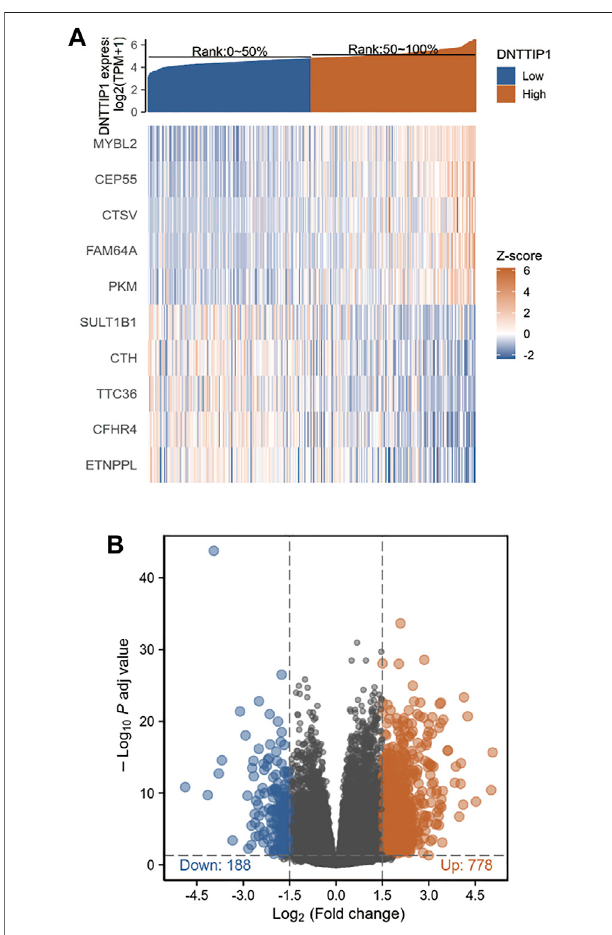
FIGURE 1 | Results of differentially expressed gene (DEG) analysis. (A) Heat map of the 10 differentially expressed genes. (B) Volcano plot of differentially expressed